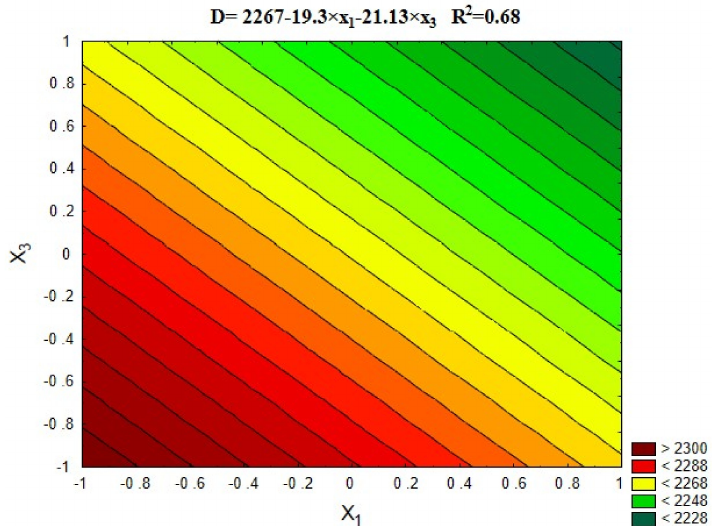
Figure 11. The changes in volume density of concrete depending on x 1 and x 3 (x 2 =